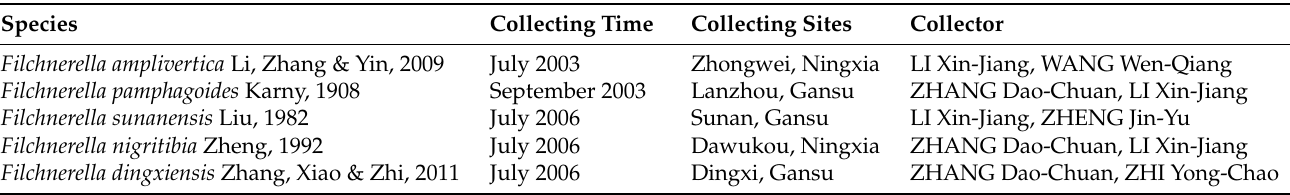
Table 1. Information on collecting samples.